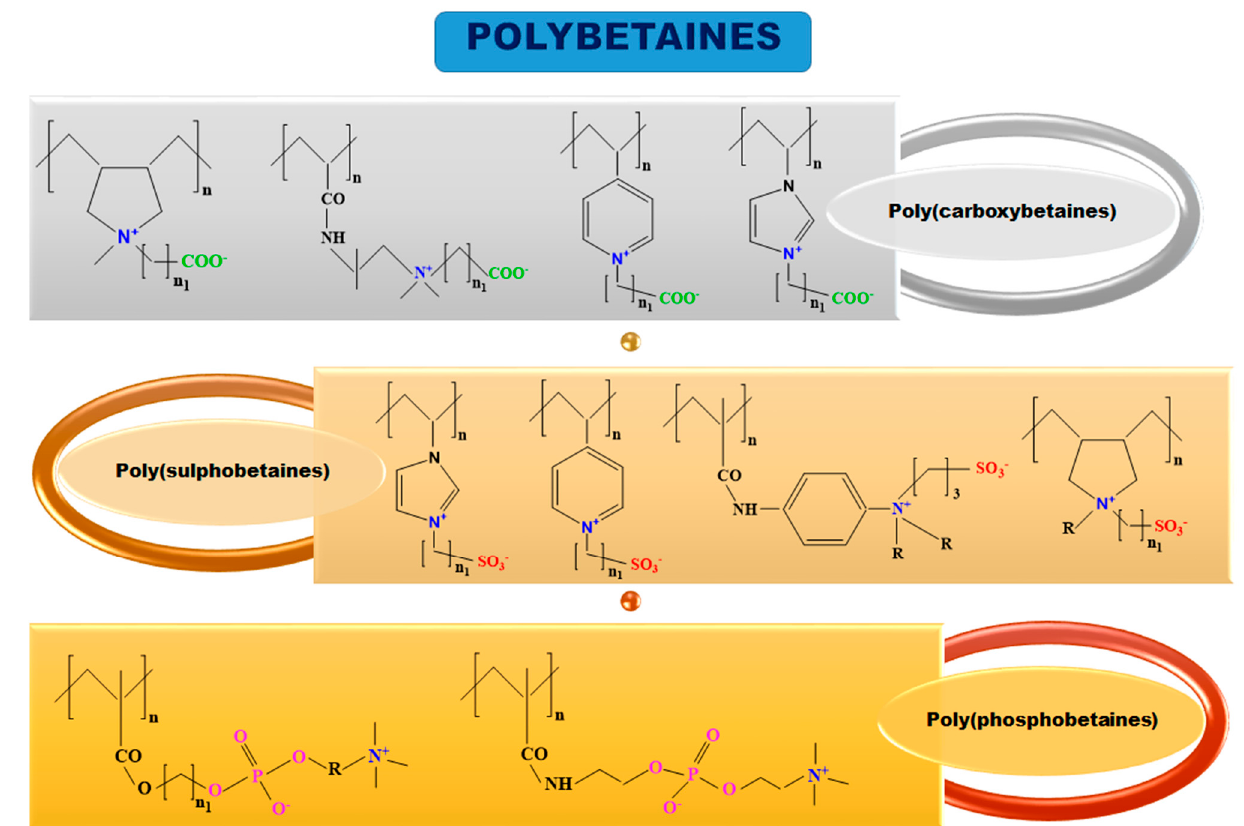
Figure 1. Types of polybetaines and some of their chemical structures .